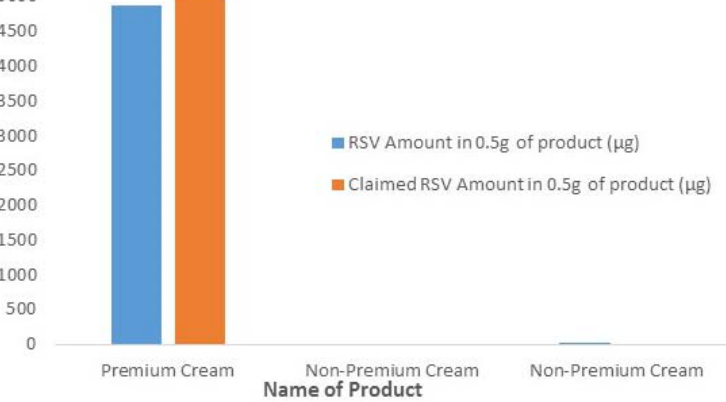
Figure 10. Amount of RSV extracted from the commercial products.